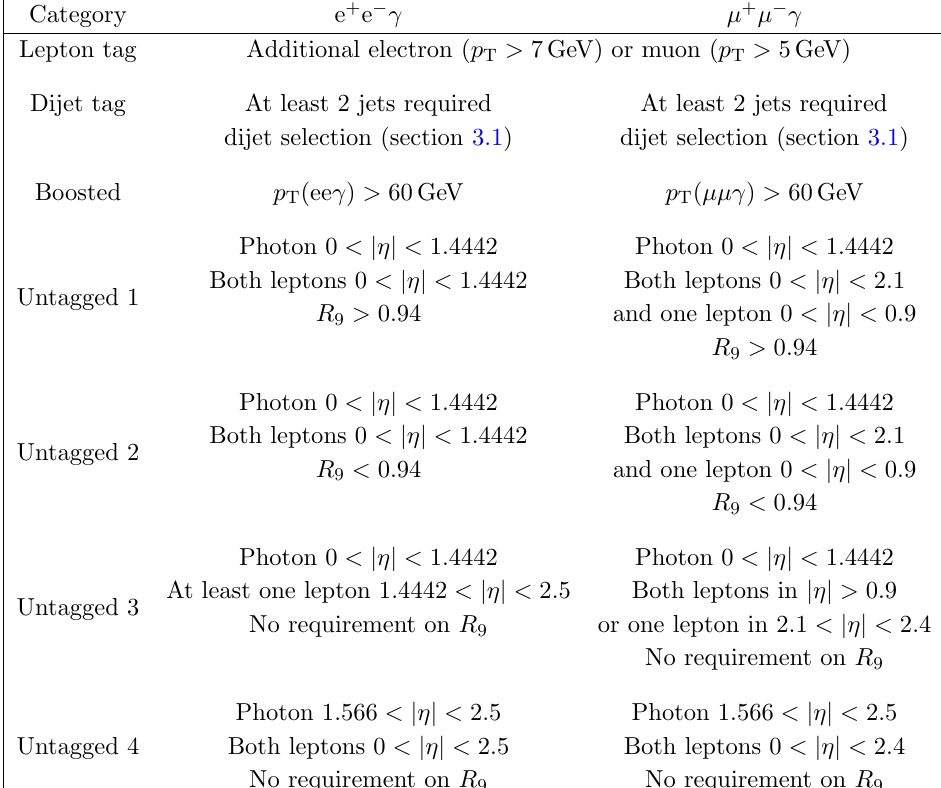
Z (cid:13) ‘‘(cid:13) search. The electron and muon channels are considered ! !